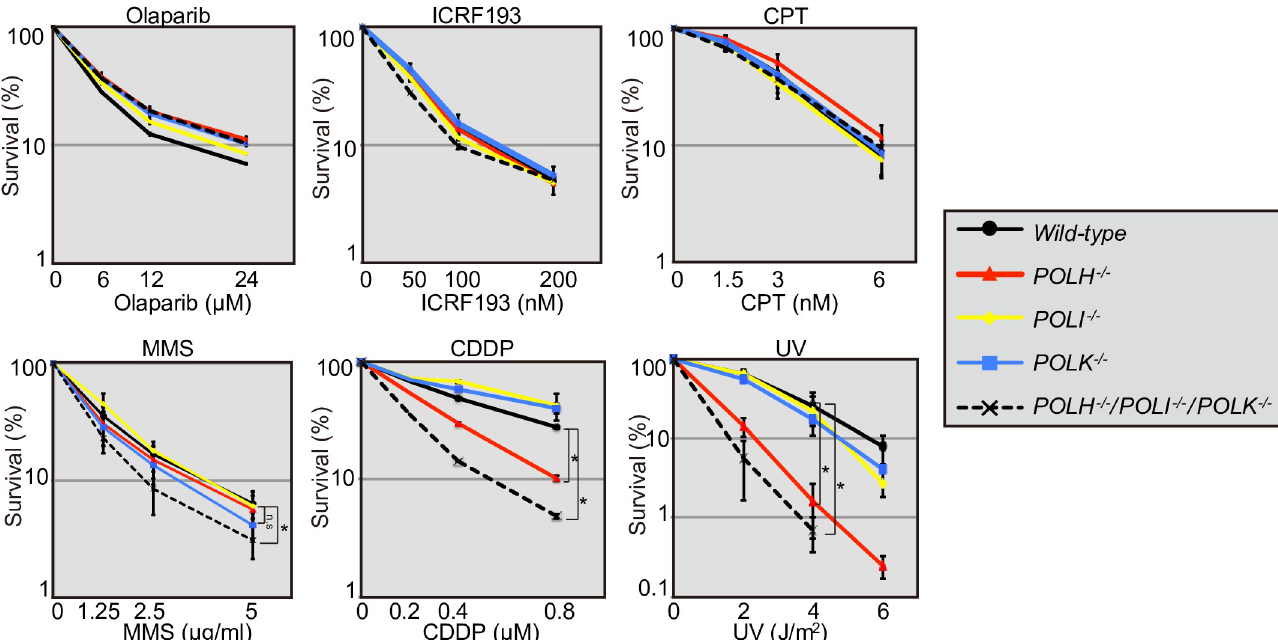
Fig 1. Role of Y-family polymerases in cellular tolerance to DNA-damaging agents. TK6 cells were assessed for sensitivity to six DNA-damaging agents. Cell viability was assessed by ATP assay, as described in the Materials and Methods. The dose of the indicated DNA-damaging agent is displayed on the x-axis on a linear scale, while the percentage of cell survival is displayed on the y-axis on a logarithmic scale. Error bars represent the standard deviation from three independent measurements. The p -value was calculated by Student’s t -test ( � p < 0.05 and n.s [not significant]).